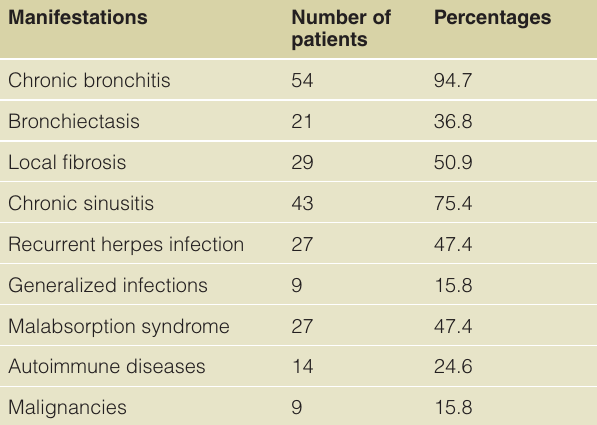
Table 2. Main clinical manifestations of